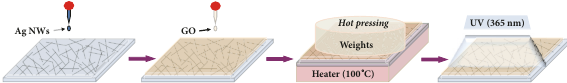
Figure 1: Schematic diagram of the fabrication procedure for Ag NWs/r-GO composite electrode.